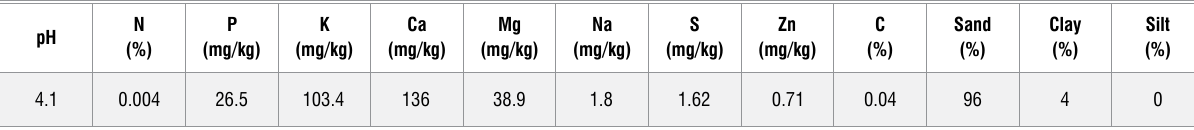
Characteristics of the applied soil and the measured nutrient content pH